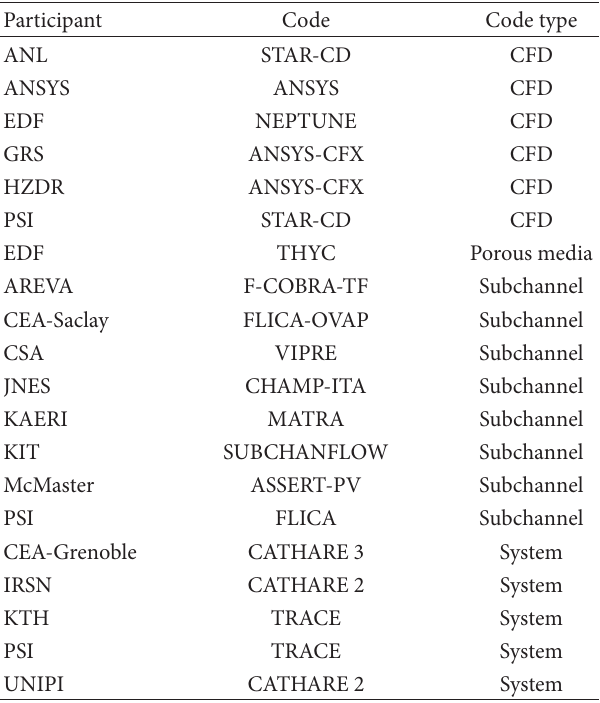
Table 14: Phase I, exercise 1 participants and code list.